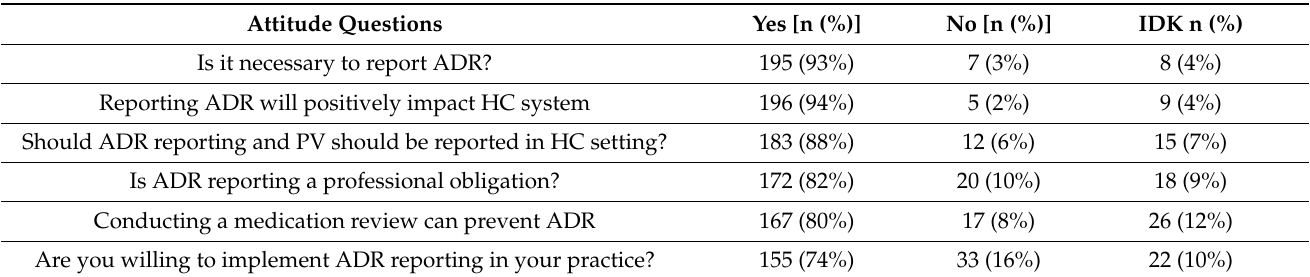
Table 3. Attitude towards PV and ADRs reporting (n = 209).